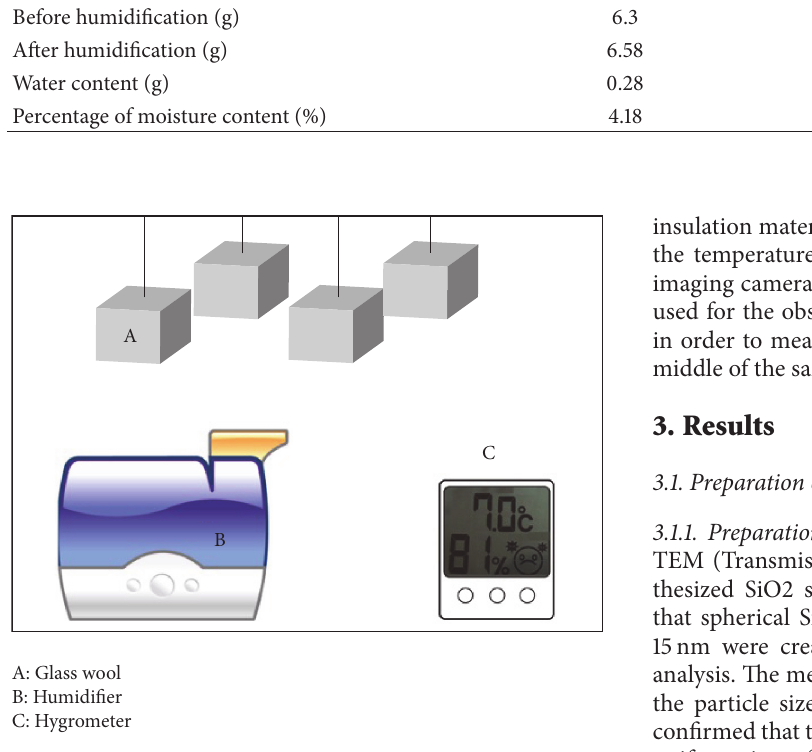
Figure 3: Schematic drawing of the whole experimental